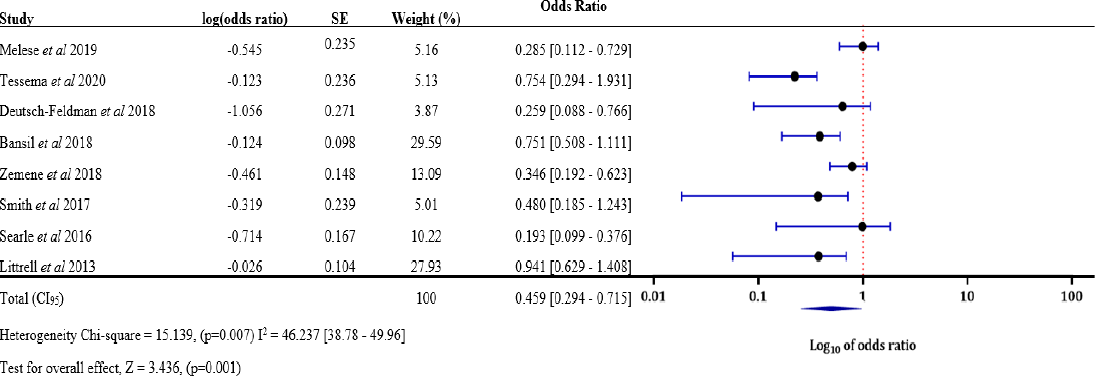
Figure 5. Malaria infection risk in neighbours of index cases compared with index case household members after sensitivity analysis [24,36,38,41,43,49,58,64]. SE: Standard Error, Log(odds ratio) values with “-“ are negative.